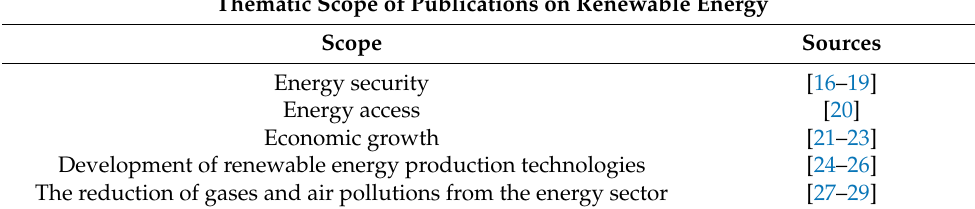
Table 1. Thematic scope of publications on renewable